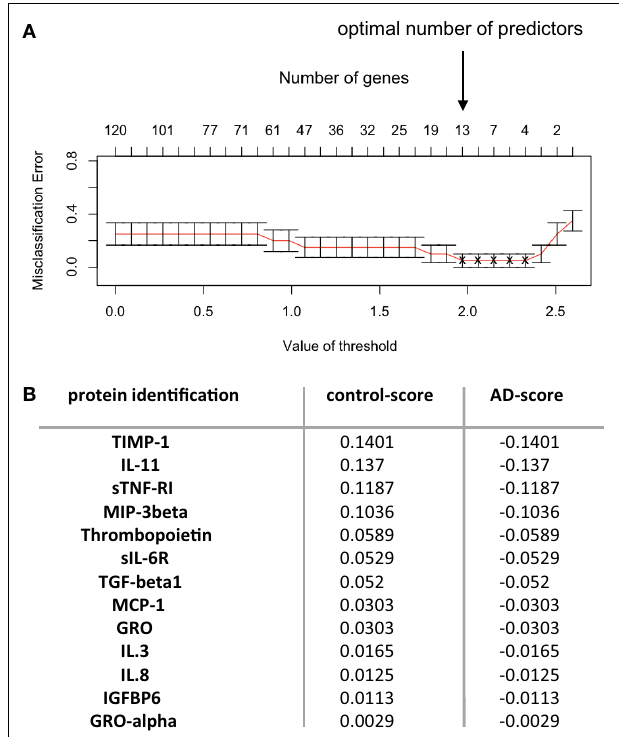
FIGURE 2 | Predictors discovery . (A) Predictor discovery by prediction analysis for microarrays (PAM) was performed with normalized array measurements of 120 signaling proteins in the training set. Internal cross-validation (redline) decreasing the centroid threshold (lower x -axis) resulted in an increase in the number of markers (inserted upper x -axis) that were used for classification and calculation of the classification error ( y -axis). This led to the discovery of an optimal set of 13 predictors with lowest possible classification error. (B) The 13 predictors identified through PAM analysis are presented. Proteins are arranged in columns, with d -score corresponding in each group. Control group corresponded to control subjects and MCI non-AD patients (groups A–C defined for protein-arrays analysis); AD group corresponded to AD late-stage patients and MCI presenting AD profile (groups B–D defined for protein-arrays analysis). Positive d -score is indicative of increased expression and negative d -score reflects decrease in the expression of the proteins